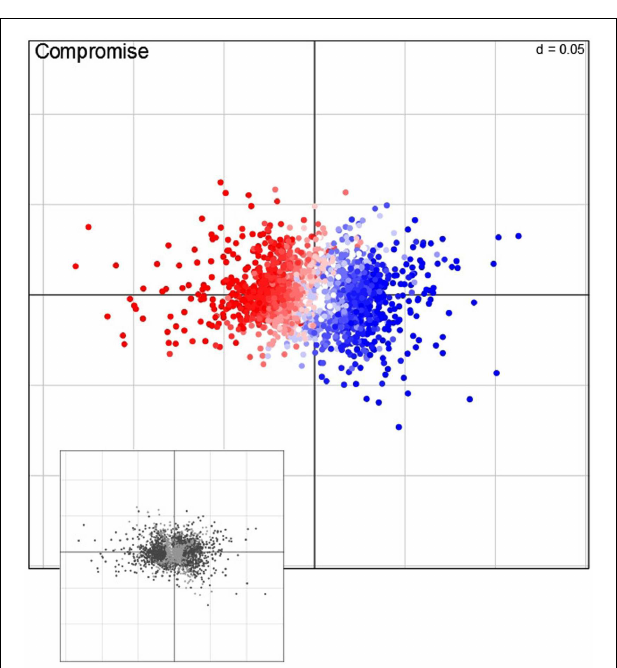
FIGURE 5 |Visualization of the compromise. Each point represents one of the 2,276 genes, i.e., observations, projected on the first and second principal component. Red (repression) and blue (induction) color corresponds to the direction average fold-change of expression levels (main panel); the color intensity correspond to the magnitude of change. Genes that exhibit a significant contribution, as determined by bootstrapping procedures, are colored in dark, non-significantly contribution genes in light gray (lower